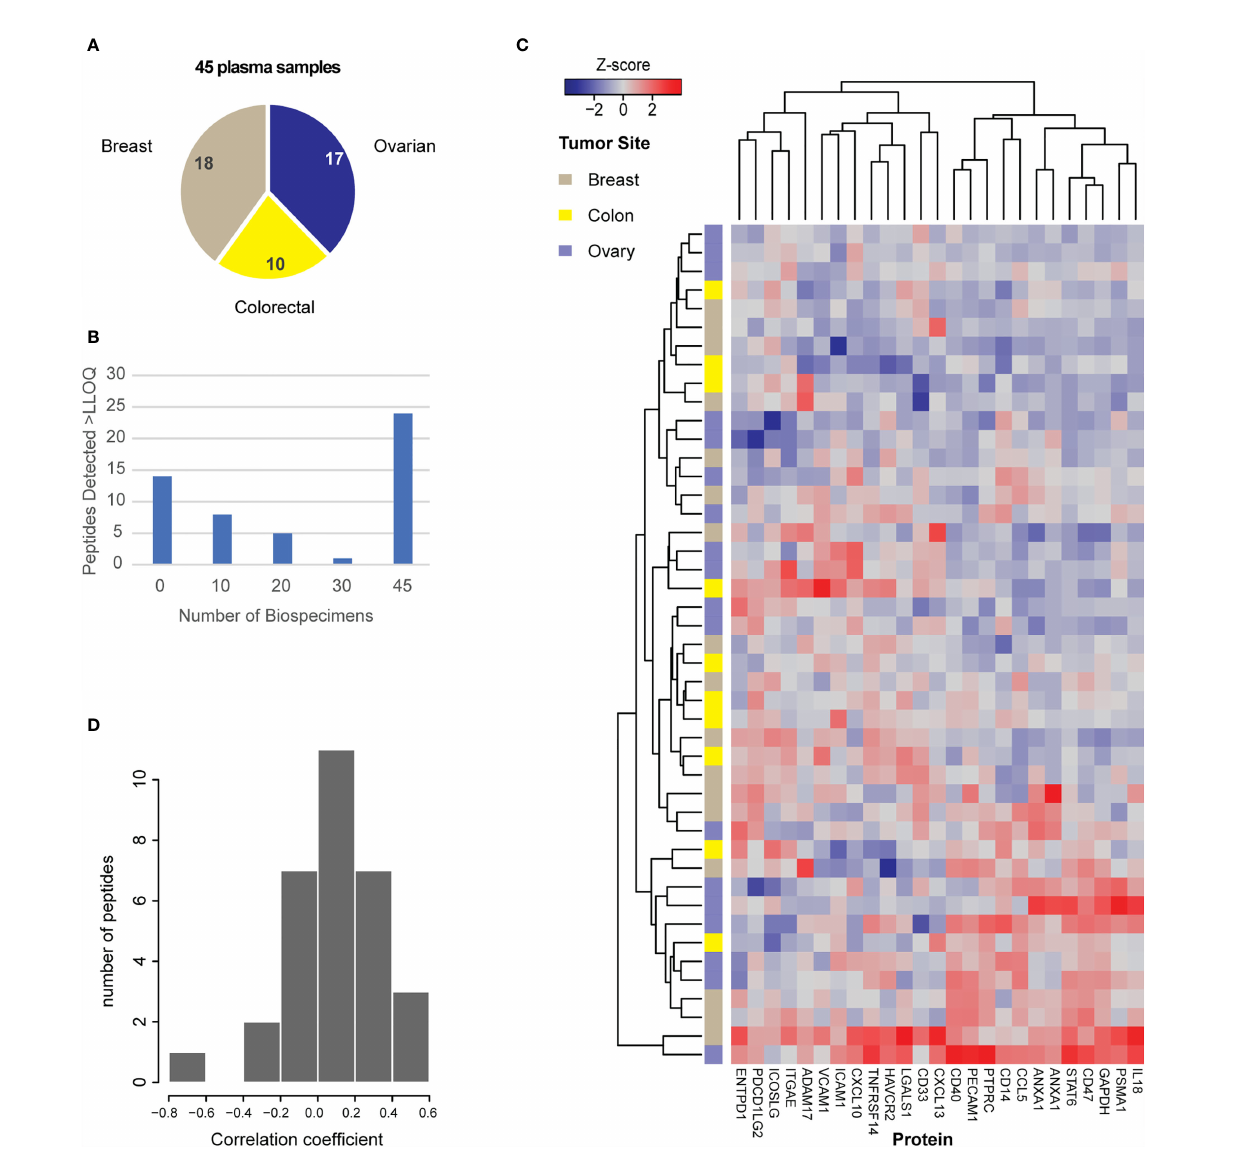
FIGURE 4 | Utility of the assays for measurement of protein expression in plasma. (A) Plasma samples were obtained for 45 patients with breast, colorectal, or ovarian tumors, as indicated in the pie chart. (B) Distribution of peptide detection plotted as a histogram, showing the number of peptides detected above LOQ across the 45 plasmas using 100 m L aliquots of plasma as input. (C) Heatmap showing unsupervised clustering of analytes detected above LOQ in >50% of plasma samples. Peak area ratios (light:heavy) were normalized for each peptide analyte, and the z-score was used for clustering. (D) Histogram showing the correlation of protein expression levels in patients for whom both tissue and plasma samples were